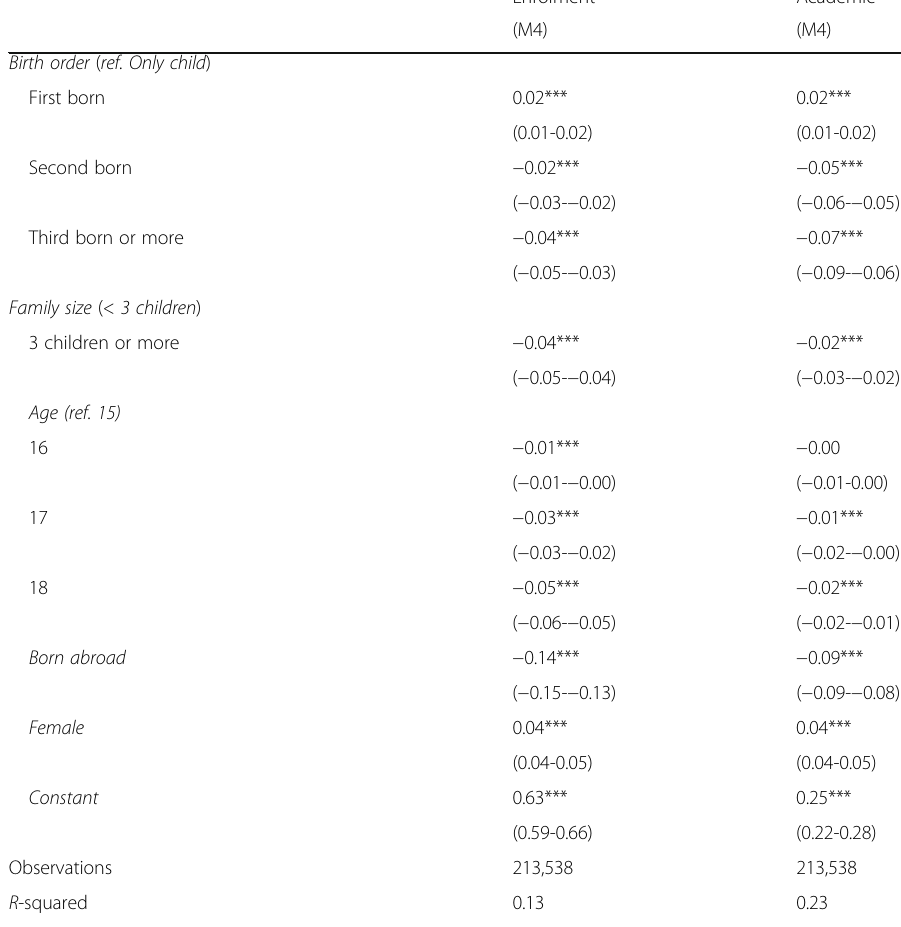
Table 1 Beta coefficients (with 95% c.i.) of control variables from Figs. 1 and 2 (model